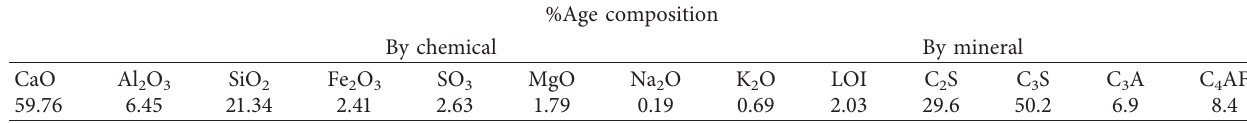
Table 2: Compound composition of cement.